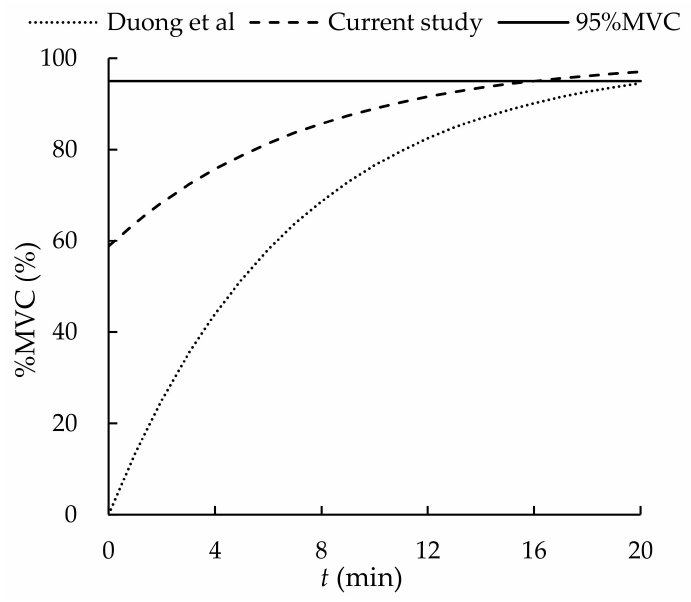
Figure 8. Recovery of muscle